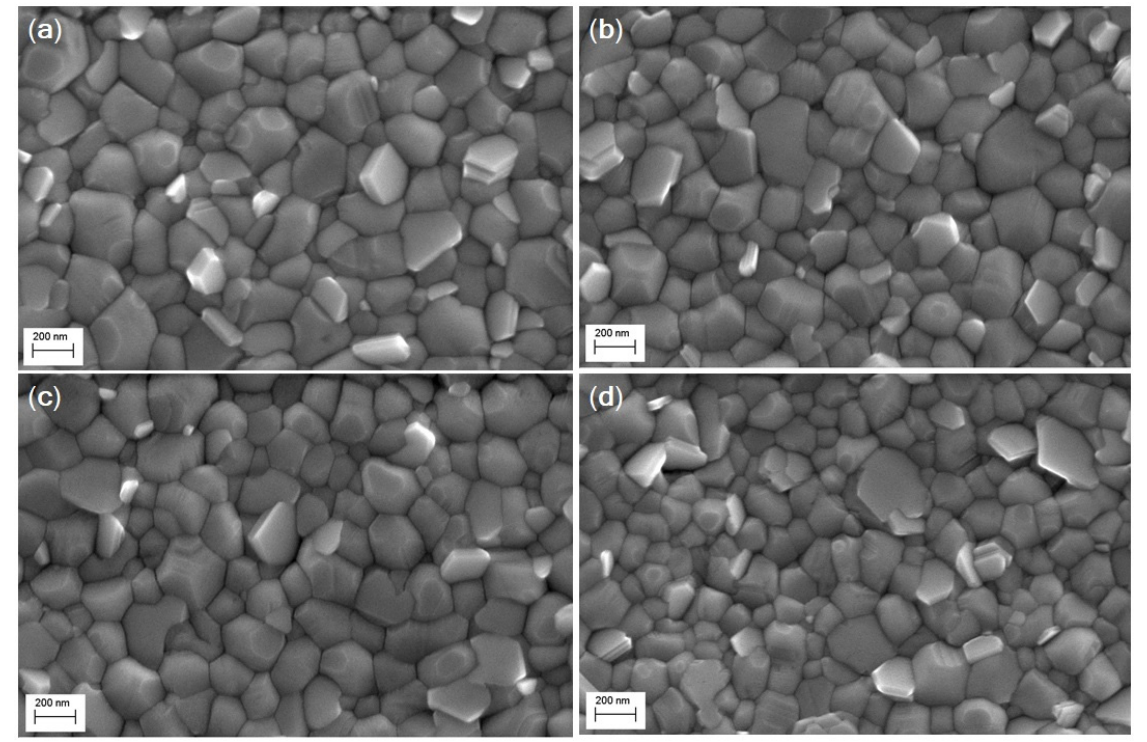
Nanomaterials 2021 , 11 , x FOR PEER REVIEW Figure 5. Top-view SEM images of the as-prepared CsMAFAPbIBr perovskite thin films, with and without MoS 2 additive: ( a ) CsMAFAPbIBr; ( b ) CsMAFAPbIBr + MoS 2 (5%); ( c ) CsMAFAPbIBr + MoS 2 (10%); ( d ) CsMAFAPbIBr + MoS 2 (20%).